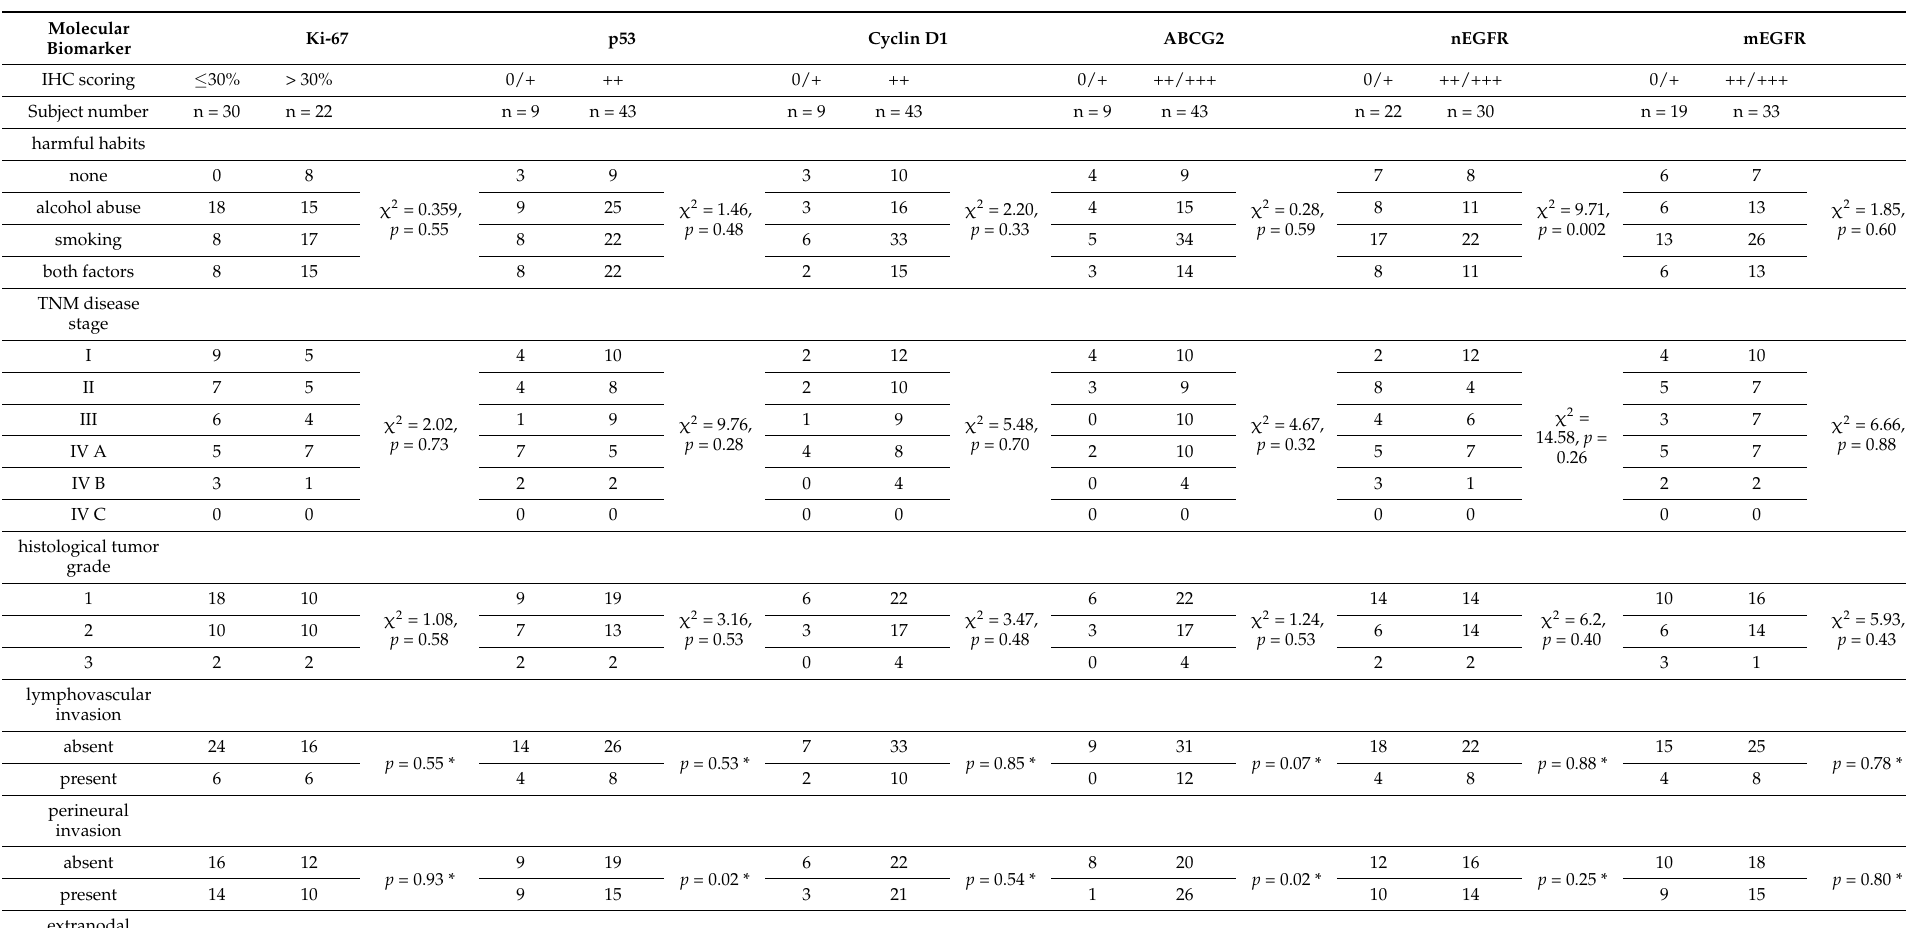
Table 2. Associations of expression of investigated molecular biomarkers with clinical data and pathohistological features of